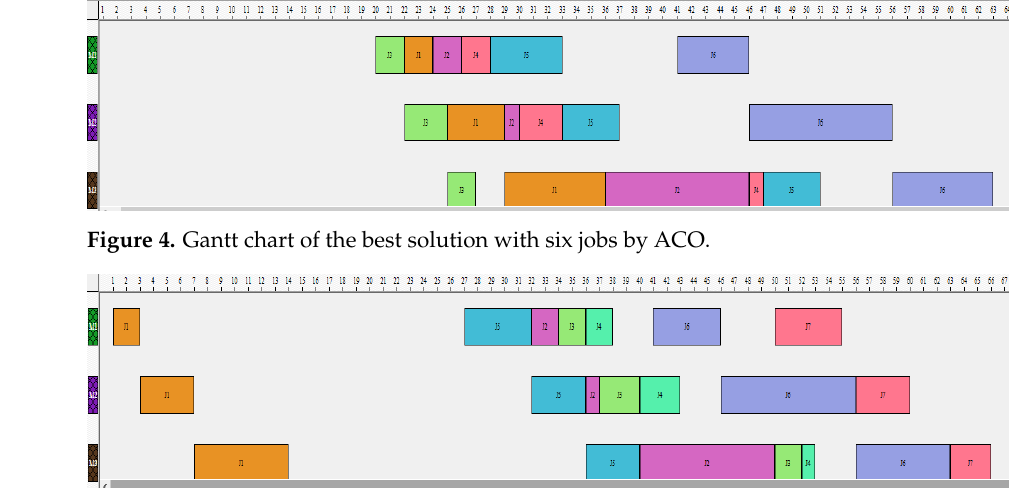
Figure 5. Gantt chart of the best solution with seven jobs by GA.